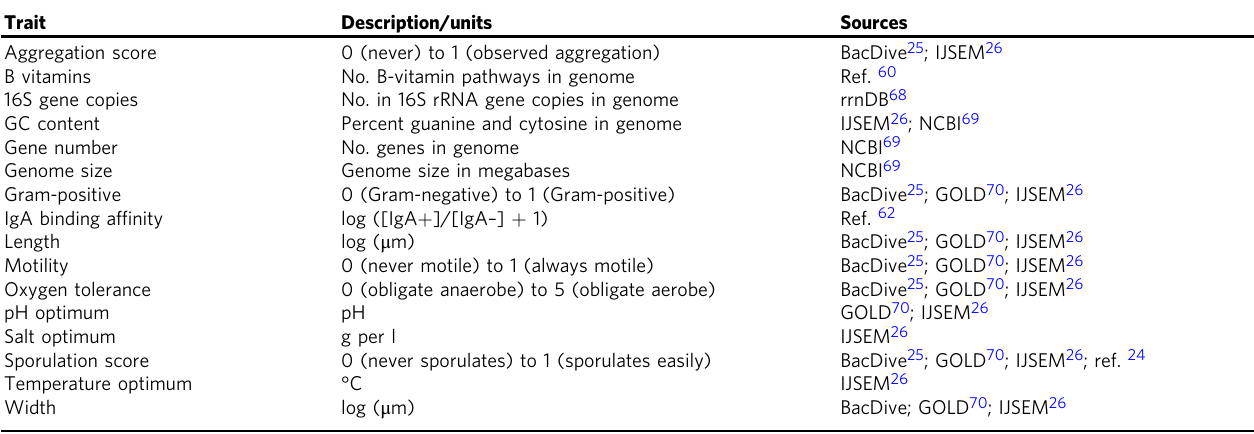
Table 1 Sources of trait data gathered in this study